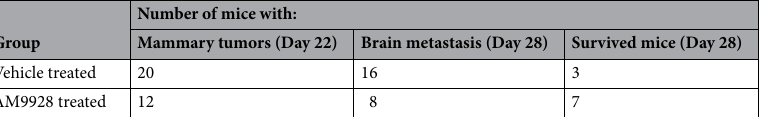
Table 1. In vivo effects of AM9928 on survival of mice following TNBC administration: summary of number of mice either treated with vehicle control or with AM9928 on days 22 and 28 as indicated. The number of mice with mammary fat tumors and brain tumors are shown. The number of mice that survive at day 28 are indicated.